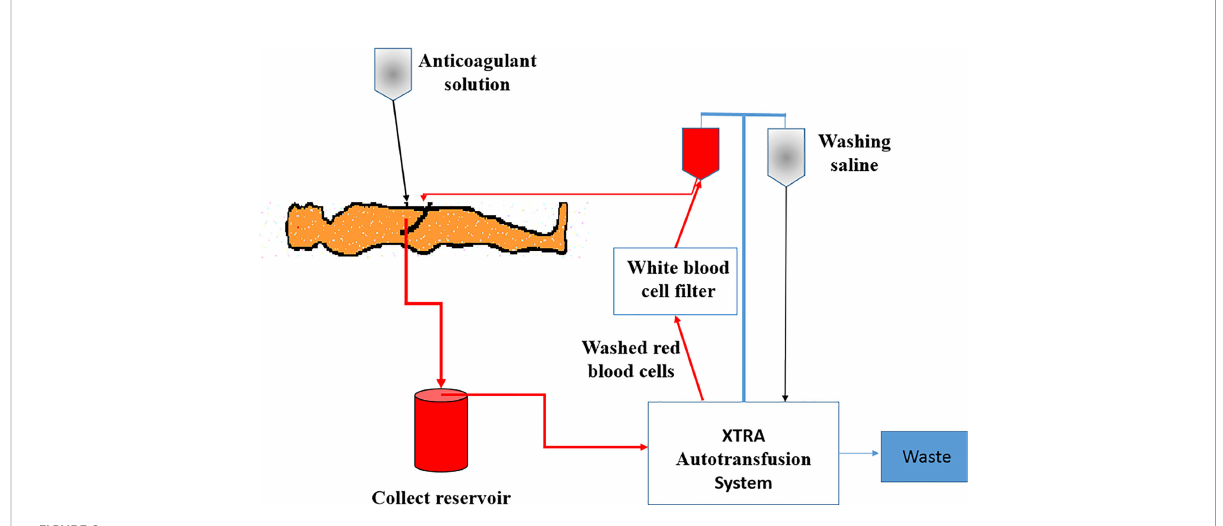
FIGURE 2 Illustration of intraoperative cell salvage